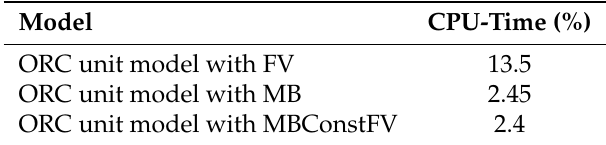
Table 4. CPU time for integration as the percentage of the total simulation